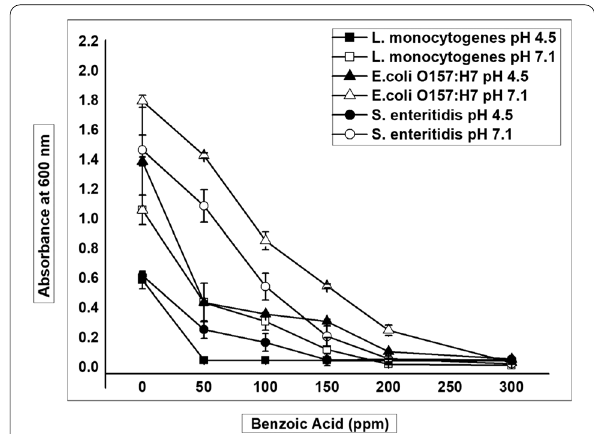
Fig. 4 Influence of different pH values on bactericidal activity of benzoic acid against E. coli O157:H7 , S. enteritidis, and L. monocytogenes . Benzoic acid concentrations (0, 5, 10, 15, 20, and 25) ppm were each added to 10-ml tryptone soya broth tubes and then inoculated ( 50 μl) of an overnight culture of bacterial suspension (O.D 600 1.818). Tubes were incubated at 37 °C for 24 h. Negative = and positive controls were performed. The optical density of each tube was measured using a spectrophotometer. Data shown as a mean of two independent experiments with standard error ( P <